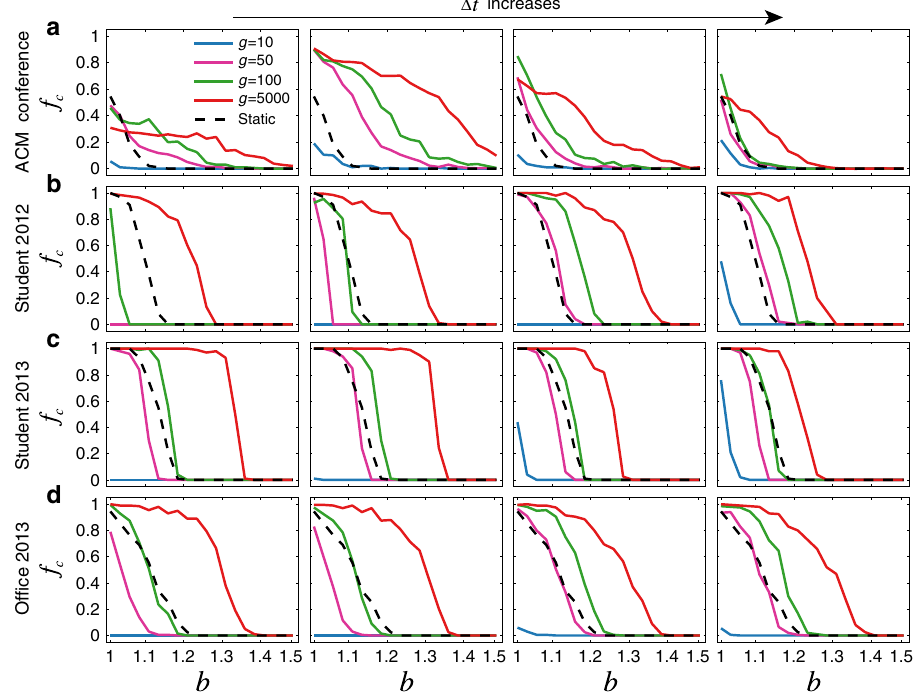
Fig. 2 Temporal networks generally promote the evolution of cooperation in real social systems. For four empirical datasets: a the ACM conference, ) on both temporal (coloured lines) and static (black dashed b Student 2012, c Student 2013, and d Of fi ce 2013, we show the frequency of cooperation ( f c lines) networks with different values of the aggregation time windows Δ t . We choose 1 ; 2 ; 6 ; 24 h from left to right in a to c and 6 ; 8 ; 12 ; 24 h in d , respectively. After letting the population evolve g rounds on each snapshot, we average over another 2000 rounds after a transient time of G ¼ 10 6 rounds on each temporal network, to obtain the equilibrium frequency of cooperators. The statistics of each dataset are given in Supplementary Table 1.